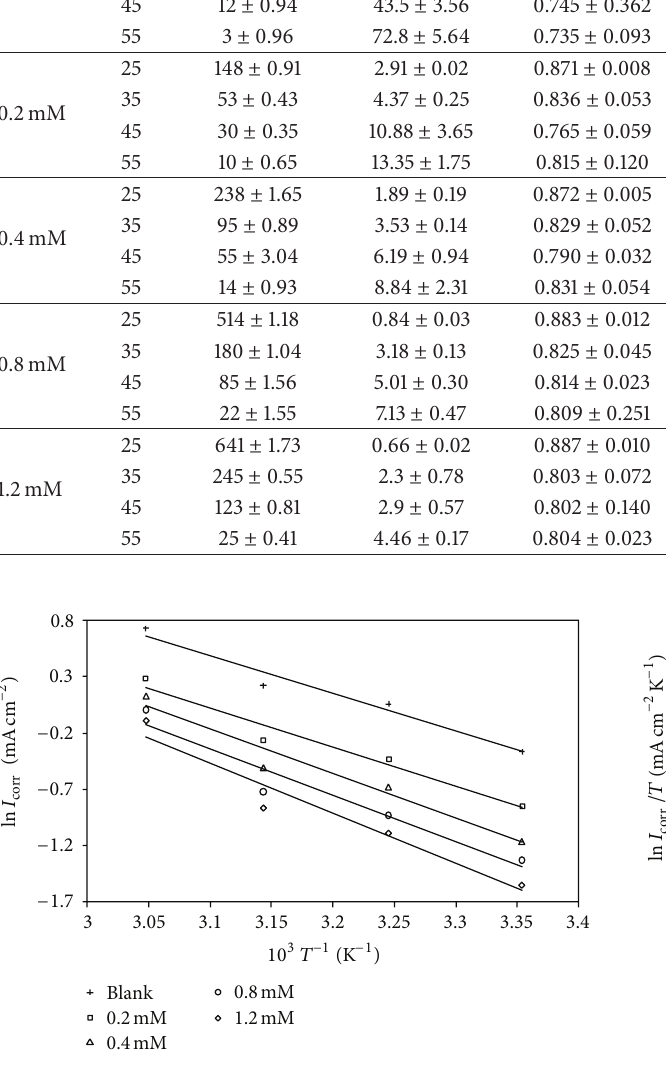
/𝑇 ) versus 1/𝑇 of 1M corr